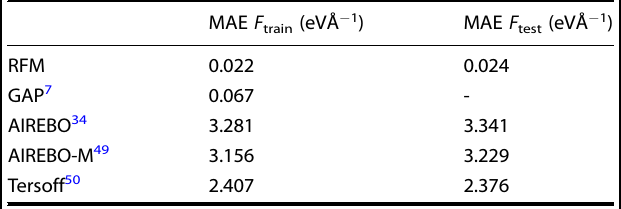
Table 2. Comparison of MAE in force predictions as predicted through RFM and other existing IPs for the diamond